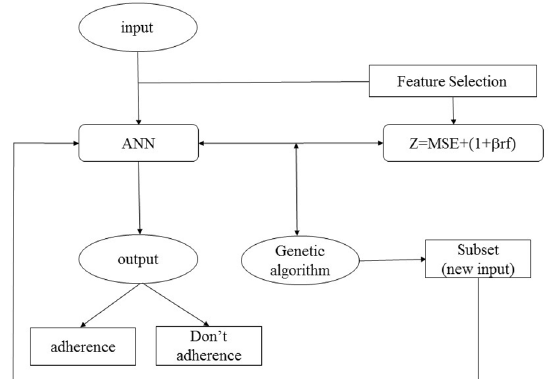
Figure 2. Implementation of GA for feature selection and developing proper factors for adherence to the